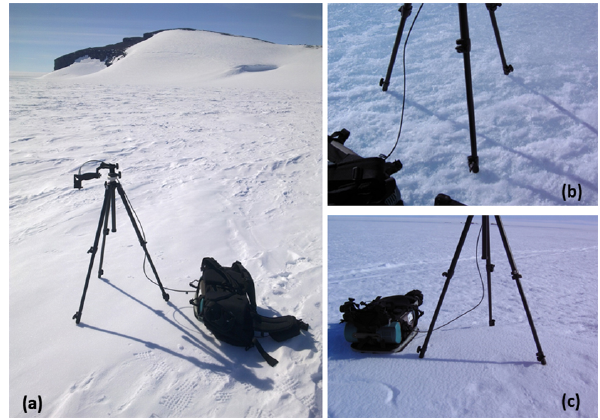
Figure 3. ASD spectroradiometer measuring snow reflectance as the surface texture changed over the measuring period: a very smooth surface on 29 December 2009 (a) , a rough surface on 5 Jan- uary 2010 (b) , and a moderately rough surface on 19 January 2010, after a light snowfall (c) .